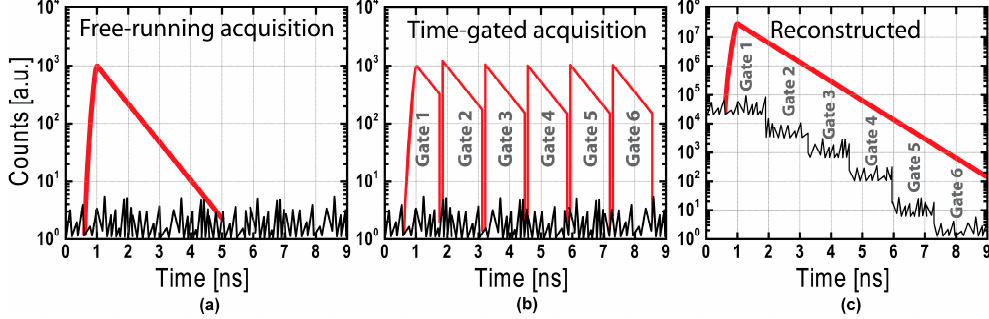
Figure 9. Schematic concept of TG optical waveform acquisition. ( a ) Optical waveform (red line) and background noise (black line) as detected by a free-running detector; ( b ) same waveform detected by a TG SPAD: different slices of the signal are acquired at different delays, increasing the signal on the detector through a variable optical attenuator to increase the photon detection rate at delays where the signal is weaker; ( c ) after normalization for the attenuation introduced, slices are combined